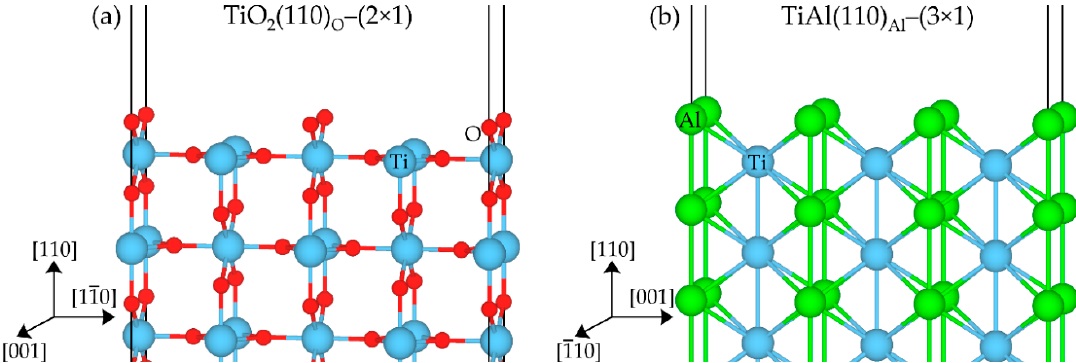
Figure 2. Atomic structure of ( a ) TiO 2 (110) O − (2 × 1) and ( b ) TiAl(110) Al − (3 × 1) surfaces.